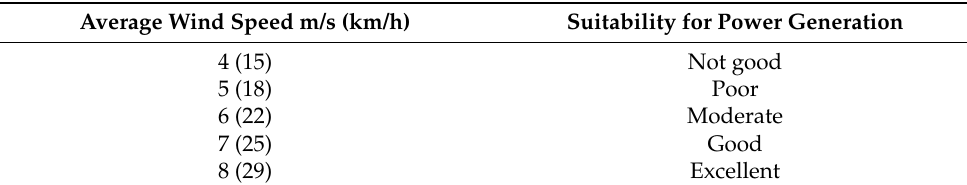
Table 1. Wind speed vs. power-generation suitability in India [15].